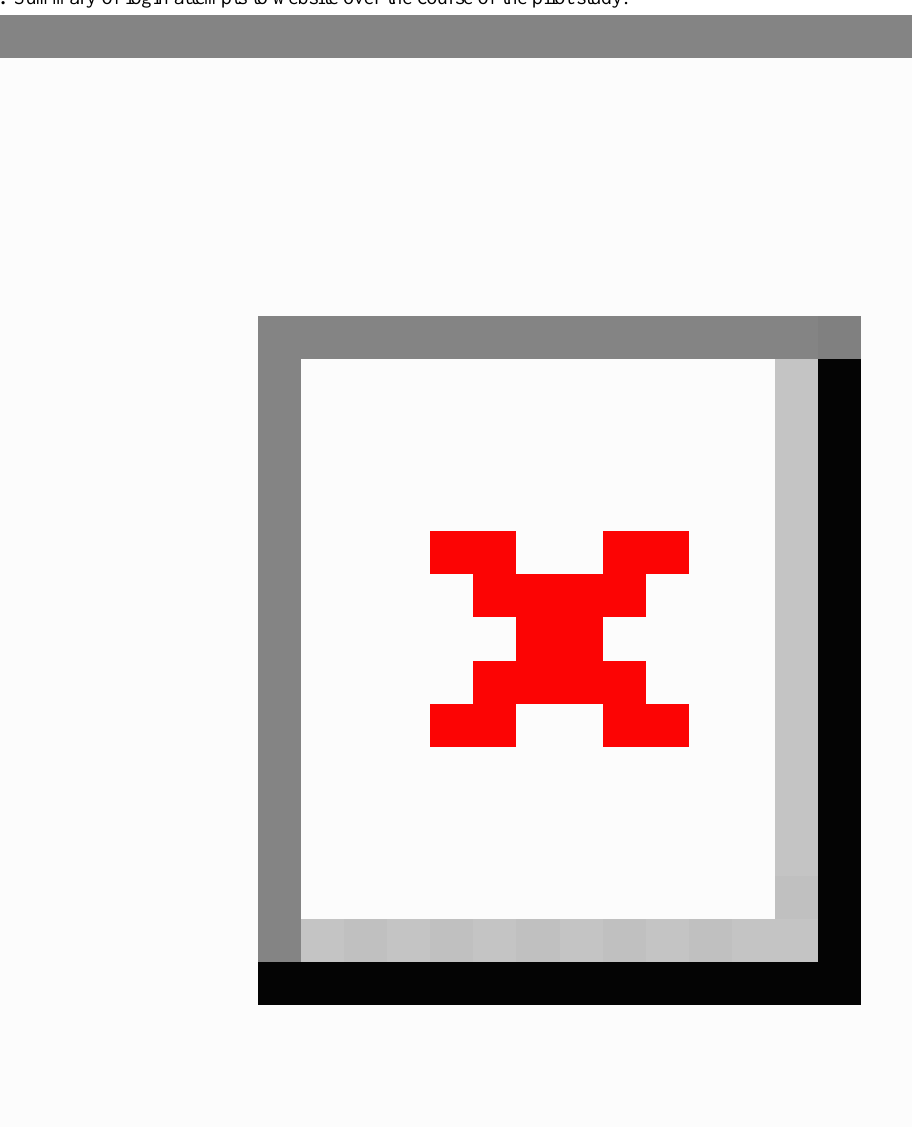
Figure 9. Summary of login attempts to website over the course of the pilot